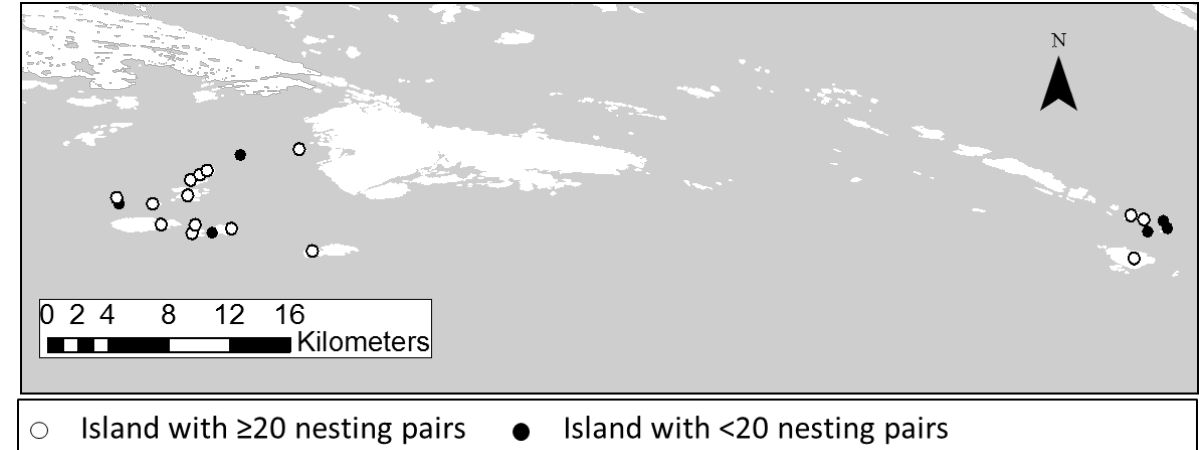
Figure A.8. Survey zone 8: West Foxe Islands, Southern Baffin